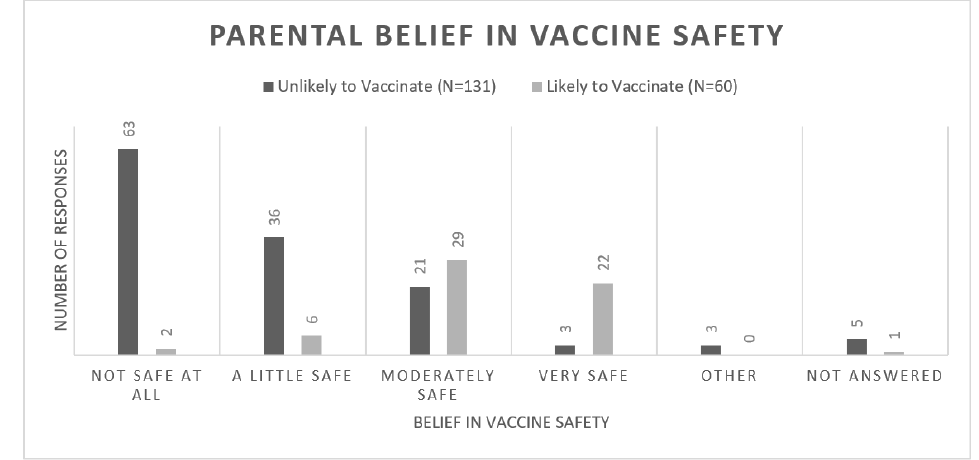
Figure 4. Bar chart displaying the number of responses versus parental belief in COVID-19 vaccine safety. There was a statistically significant difference between the two groups ( p <